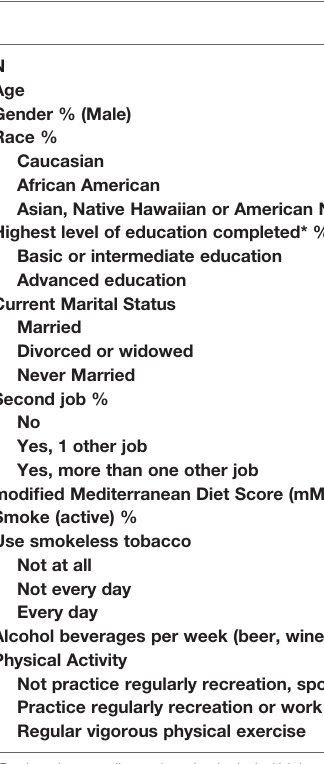
TABLE 1 | Demographic characteristics of the study